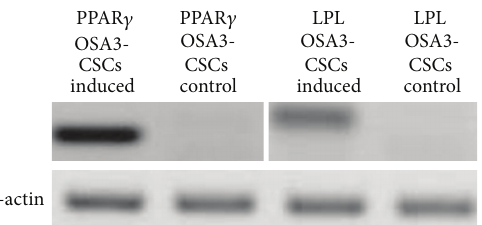
Figure 17: Expression of the adipogenic gene markers. RT-PCR show the expression of PPAR 𝛾 (left) and LPL (right), two genes involved into the adipogenic